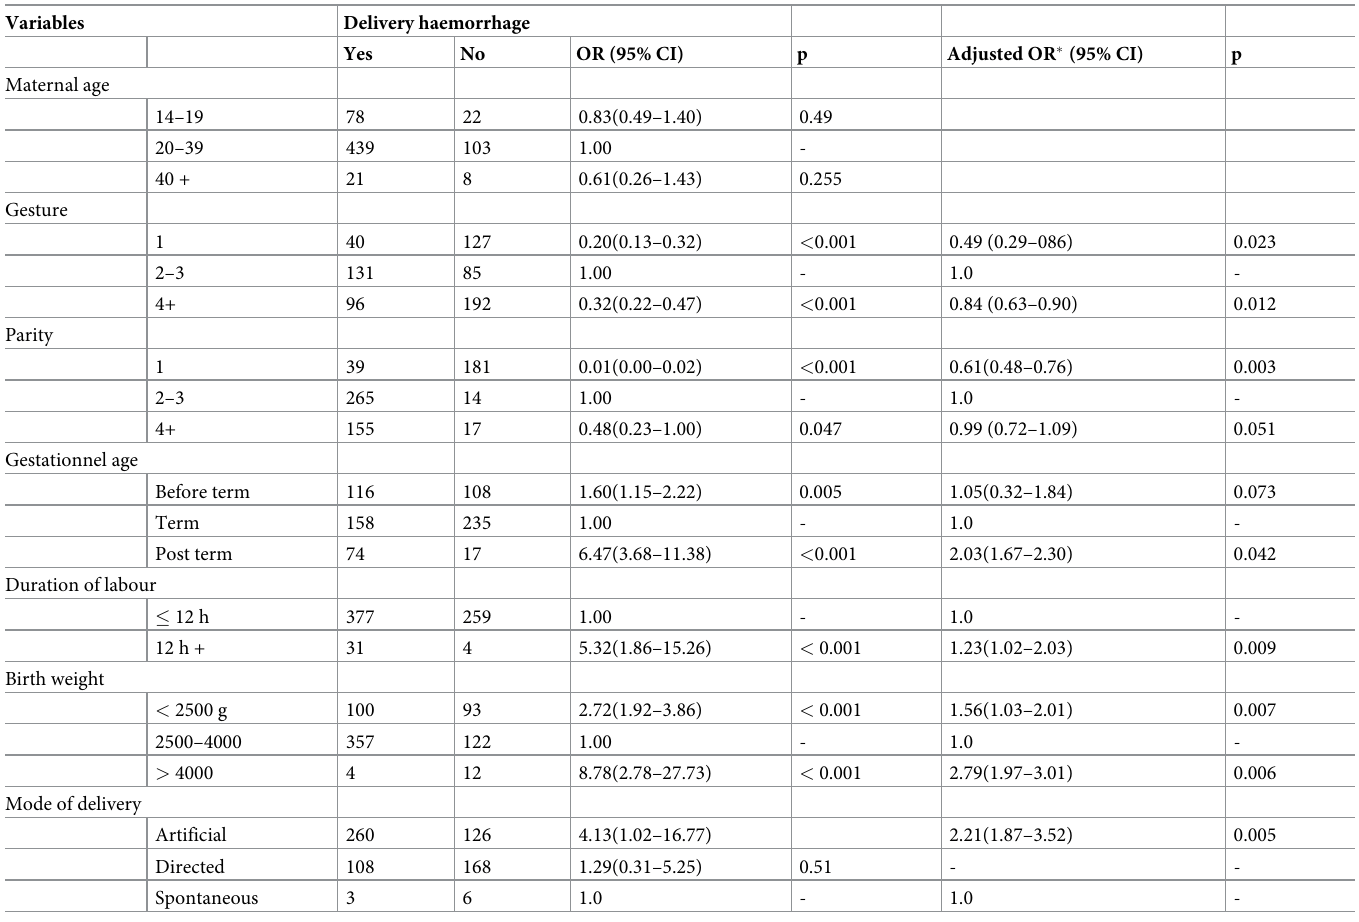
Table 4. Risk factors for PPPH with etiologies such as delivery haemorrhage in